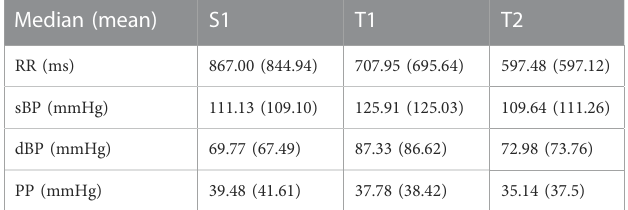
TABLE 4 The measures of the positions (median and mean) of mean values of heartbeat intervals (RR) and blood pressure (systolic, sBP; diastolic, dBP; and pulse pressure, PP) biosignals measured in vasovagal patients during 3 min of supine (S1), tilt (T1), and pre-syncope (T2) phases of the head-up tilt